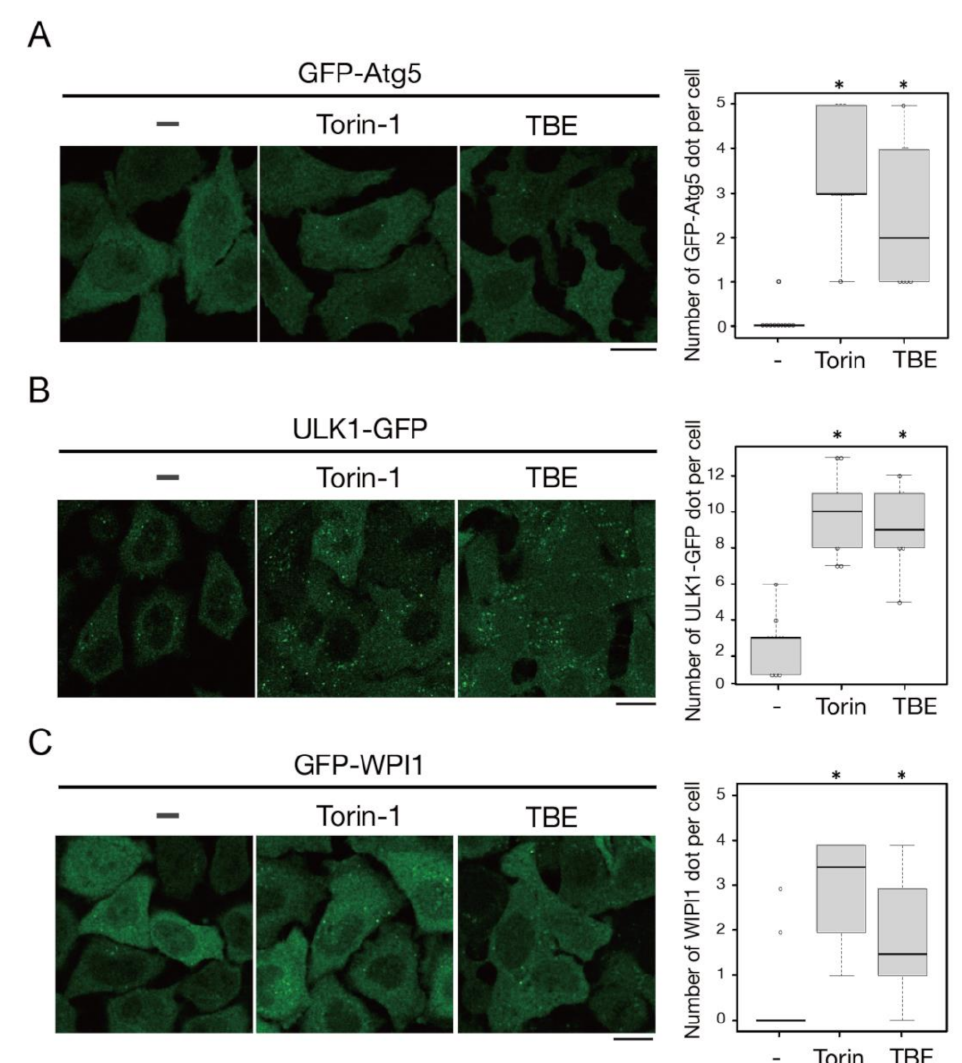
Figure 3. TBE induces autophagosome formation. HeLa cells expressing GFP-Atg5 ( A ), ULK1-EGFP ( B ), or GFP-WIPI1 ( C ) were treated with Torin-1 or TBE for 4 h. The cells were observed under a confocal microscope. The number of GFP punctae over 0.56 µ m in diameter was counted per cell, with over 20 cells in each sample. Median: line; upper and lower quartiles: boxes; 1.5 interquartile range: whiskers. Bar: 10 µ m. * denotes p < 0.05 by unpaired two-tailed Student’s t